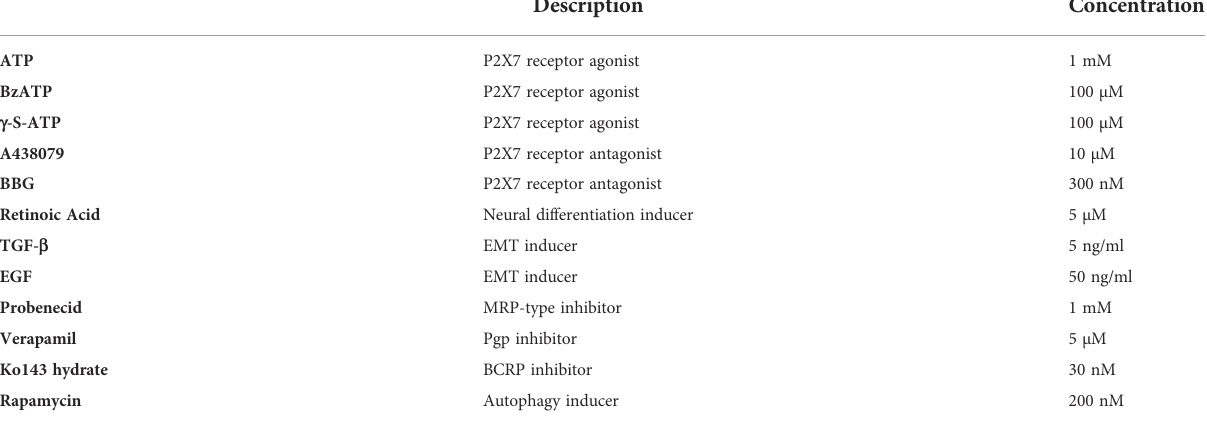
TABLE 2 Details of pharmacologic treatments other than chemotherapy